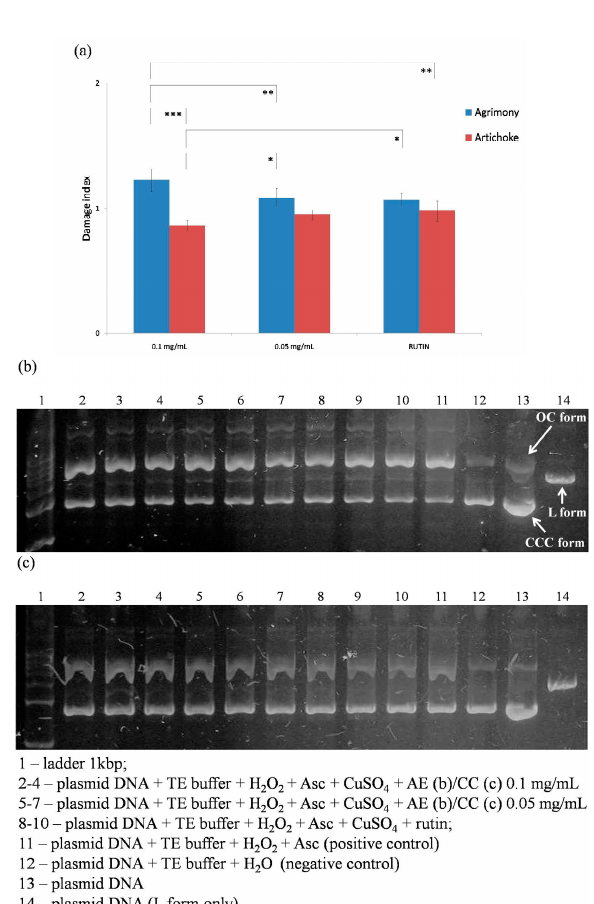
Figure 3. ( a ) Damage indexes of 0.1 mg/mL and 0.05 mg/mL agrimony and artichoke (*** p < 0.001, ** p < 0.01, * p < 0.05); ( b ) gel electrophoresis: agrimony (0.1 mg/mL and 0.05 mg/mL); and ( c ) gel electrophoresis: artichoke (0.1 mg/mL and 0.05 mg/mL).